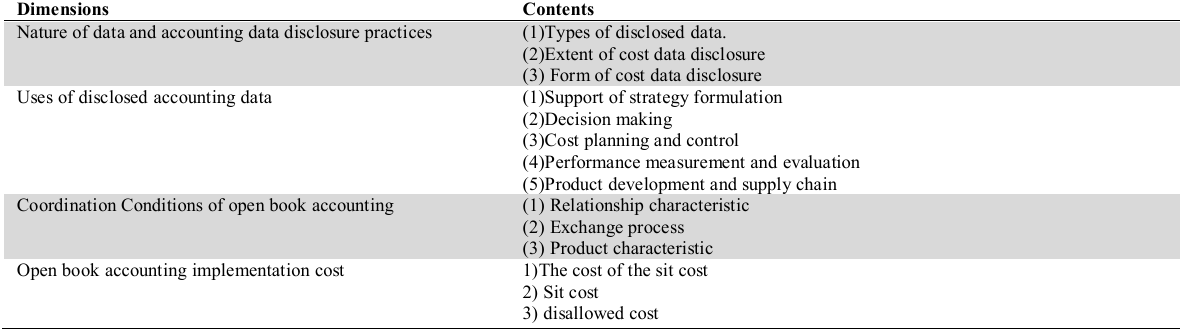
Difference perspectives of OBA Dimensions